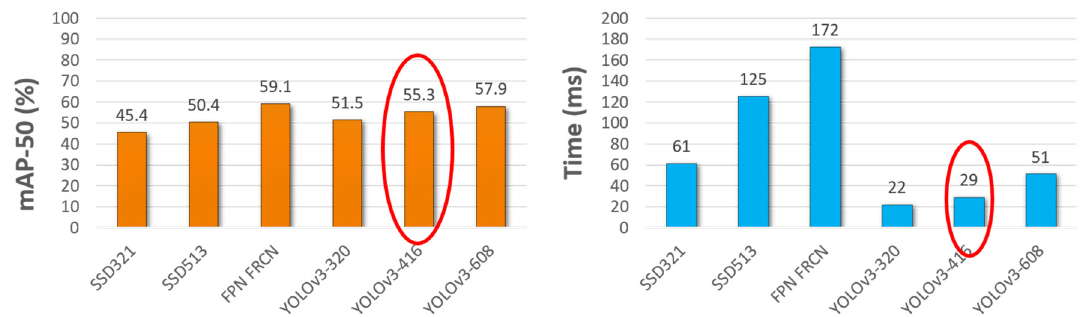
Figure 4. Performance and inference time of detection methods [13].